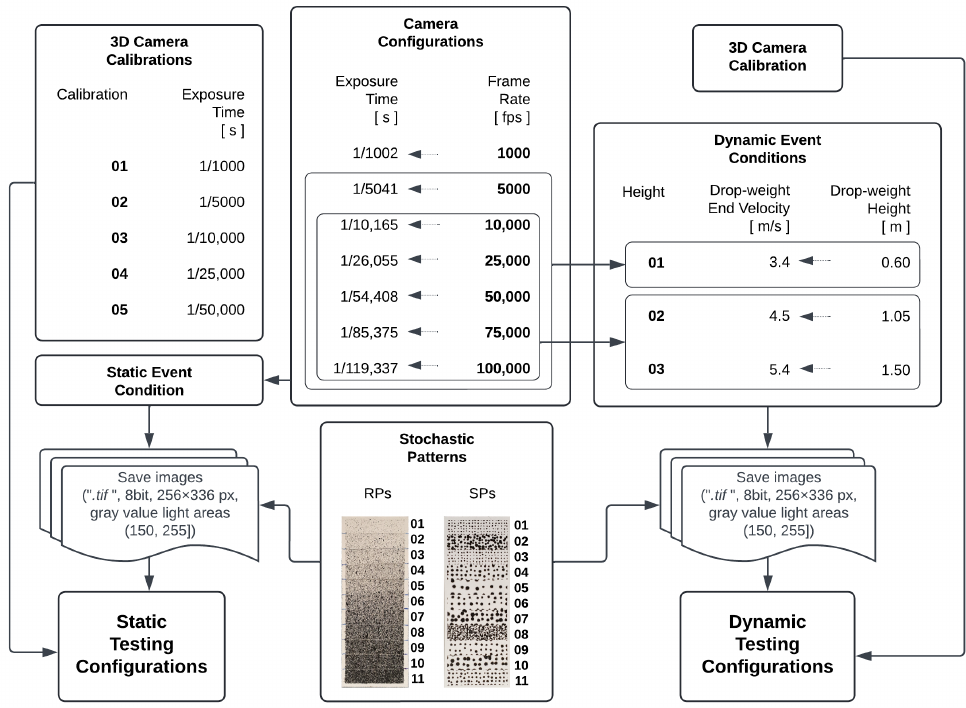
Figure 2. Testing configurations such as camera calibration, exposure time, drop-weight end velocity (cid:113) ( 2 × acceleration gravity × Height ), and pattern quality for 3D measurements in static and dynamic event conditions.